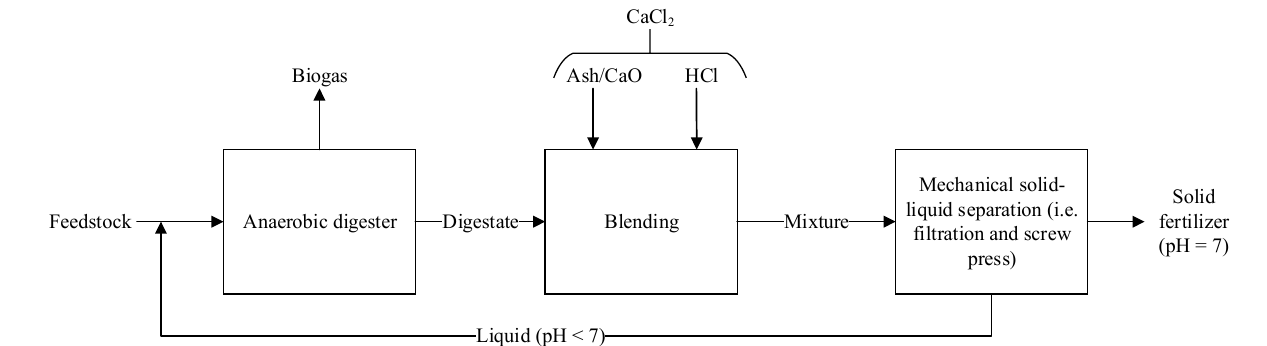
Figure 7. Proposed process A for the manufacturing of a granular fertilizer. (CHP = Combined heat and power plant) to be implemented at the headquarter of a 40,000 tonnes/year production facility of anaerobic digestate with a CHP unit for valorization of the biogas. Optimum blending ratio was defined as 5 TS HA/TS OS [31].